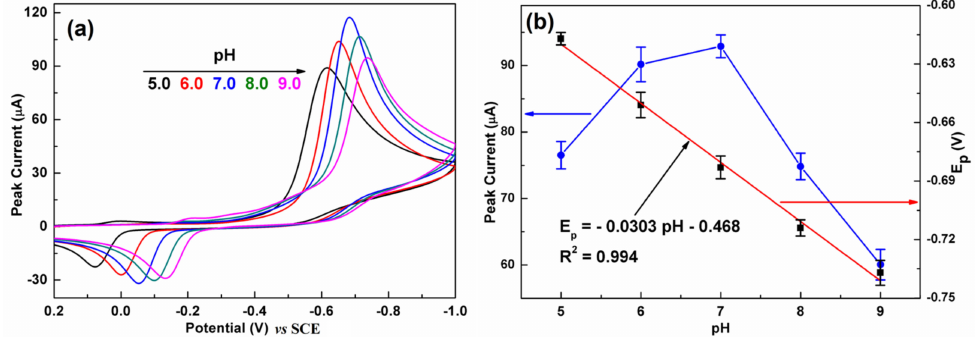
Figure 7. ( a ) CVs of C-BN/GCE at different pH (5.0, 6.0, 7.0, 8.0 and 9.0). ( b ) Dependence of the reduction peak current (left, blue curve) and E pc (right, black dots) on pH, and corresponding fitting results (red plot). (Conditions: 0.2 M PBS containing 100 µ M CAP at a scan rate of 100